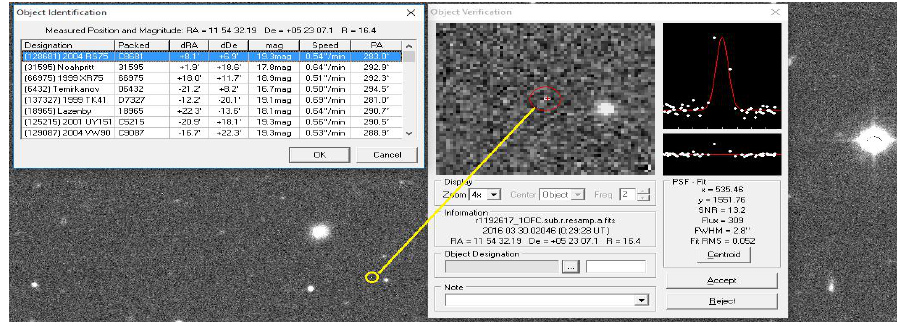
Fig.2 Detection of an asteroid using